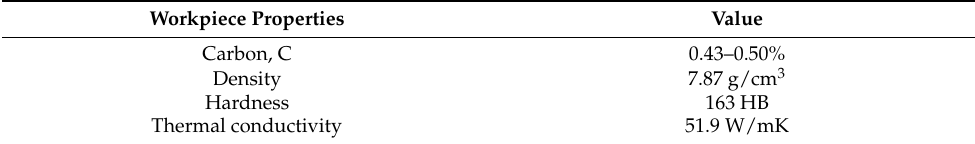
Table 2. Workpiece properties.